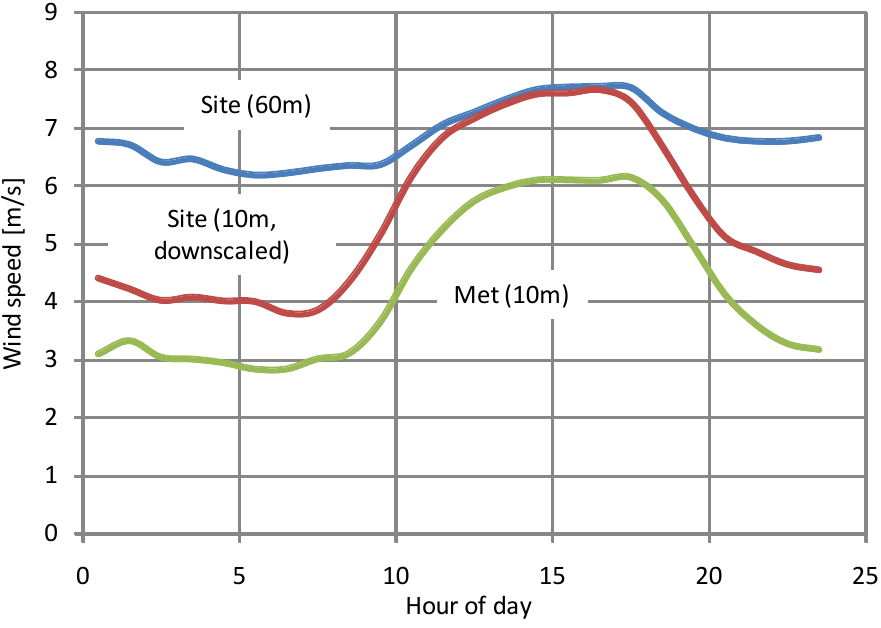
Figure 14. Daily profiles for a prospective at 60 m height above ground and downscaled to 10 m using hourly wind shear coefficients, as well as the 10 m met station